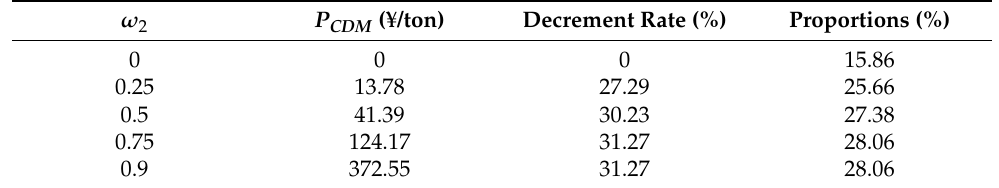
Table 6. Relationships between ω 2 , P CDM , carbon emission decrement rate and proportions of units 1 and